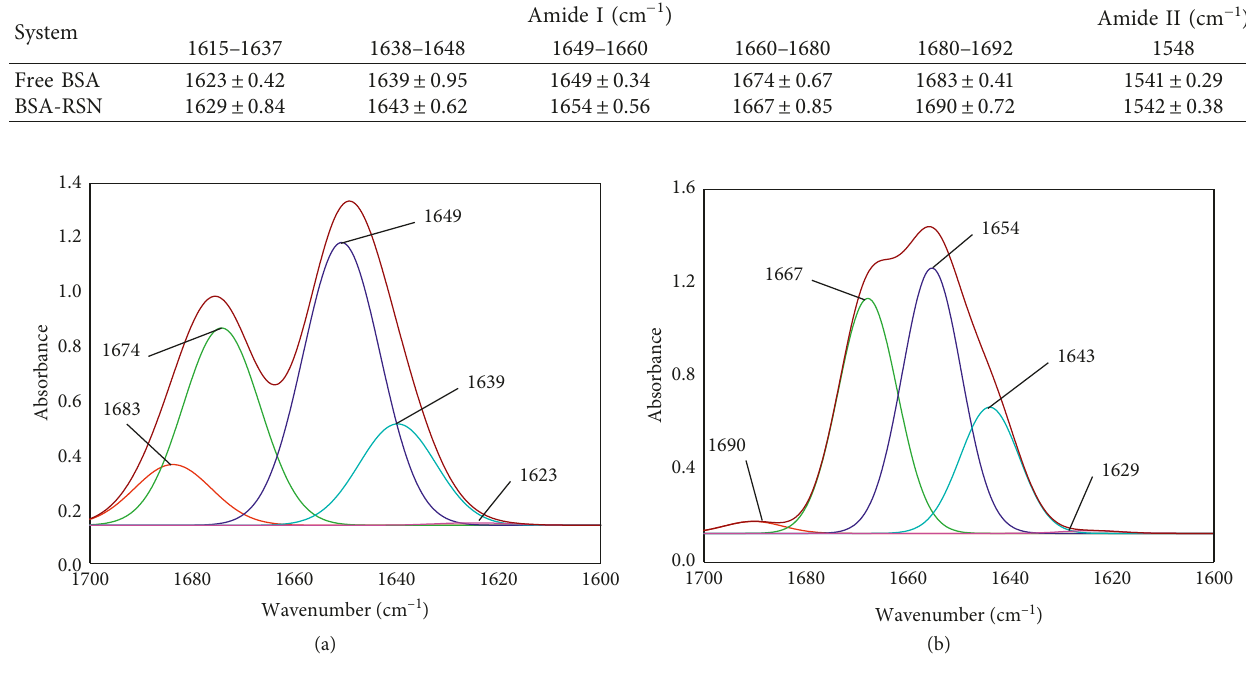
Figure 9: Amide I band (1700–1600cm − 1 ) of BSA (a) and BSA-RSN system (b) subjected to curve fitting analysis by second derivative resolution using Gaussian peak